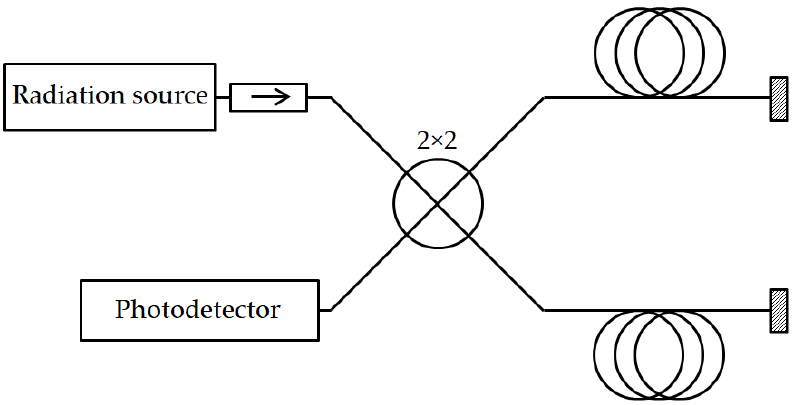
Figure 1. A basic connection of the Michelson